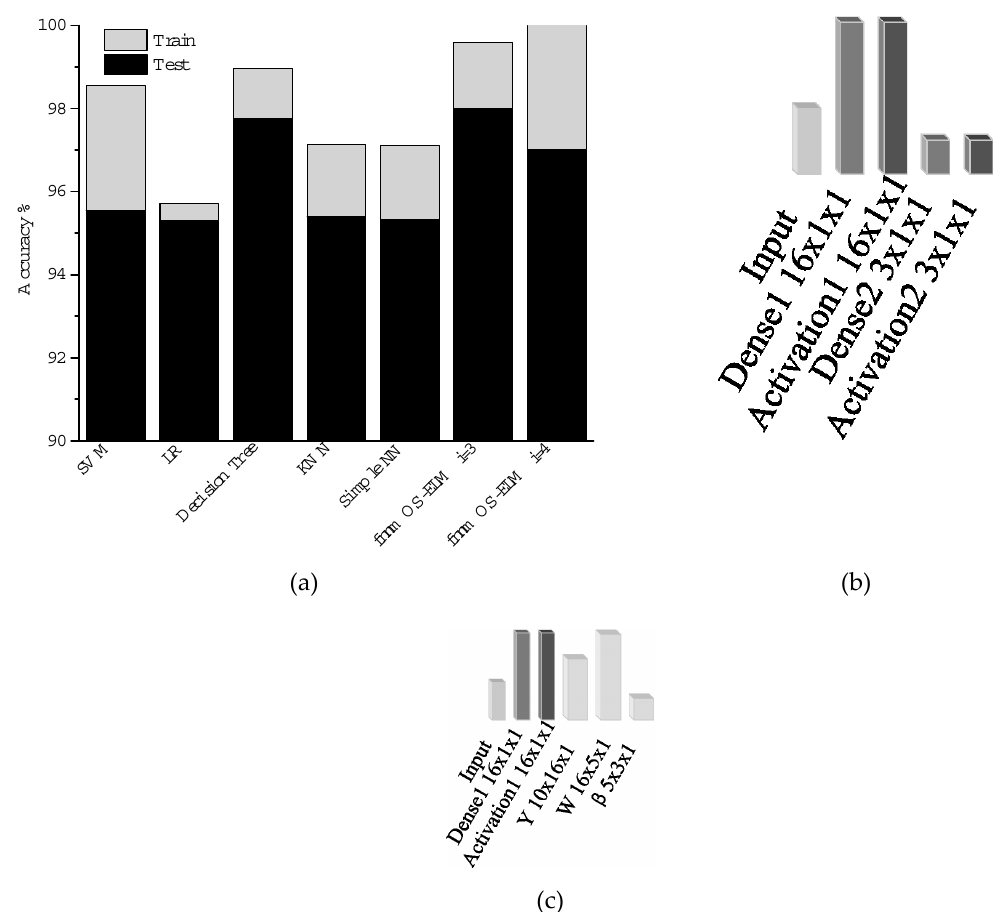
Figure 3. Comparison of six models on the Iris dataset. ( a ) Accuracy. ( b ) Structure adopted by Simple Network. ( c ) Structure of the Simple Network when 𝑖 = 3 .